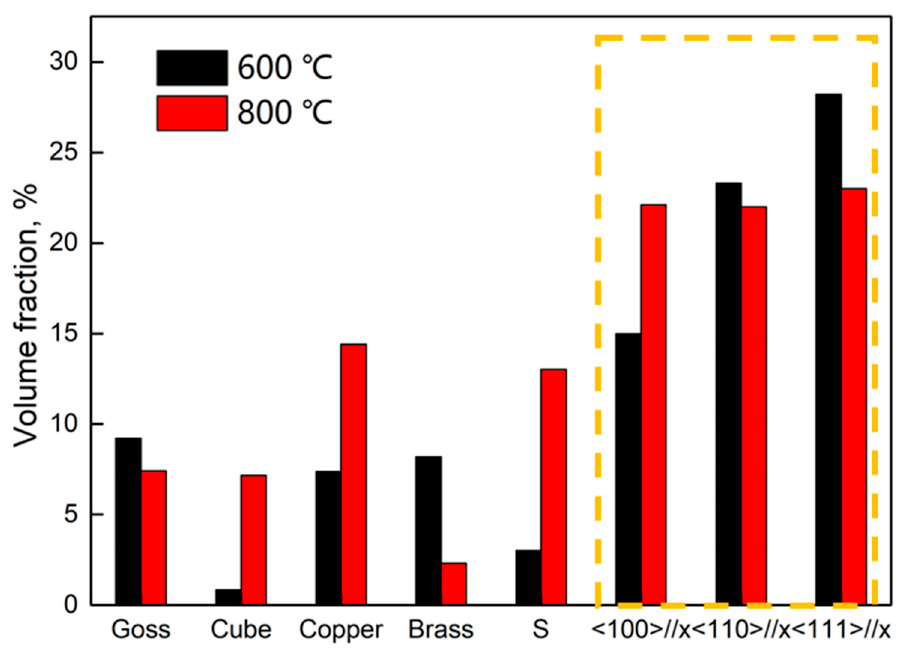
Figure 12. Texture composition of the new type of Cu-1.1–Ni-0.7–Co-0.45–Si-0.3Cr alloy at deformation temperatures of 600 °C and 800 °C.